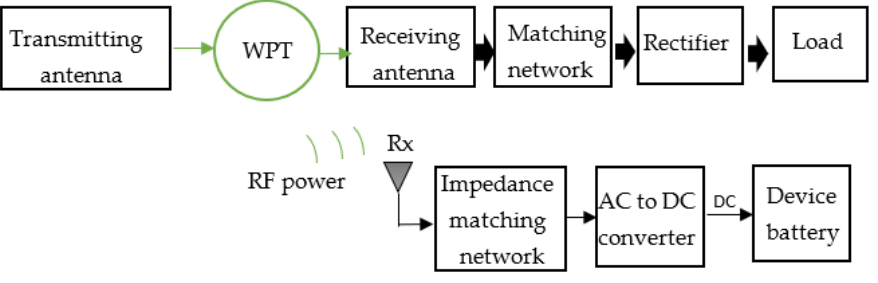
Figure 1 . Block diagram for a typical WPT system. Figure 1. Block diagram for a typical WPT